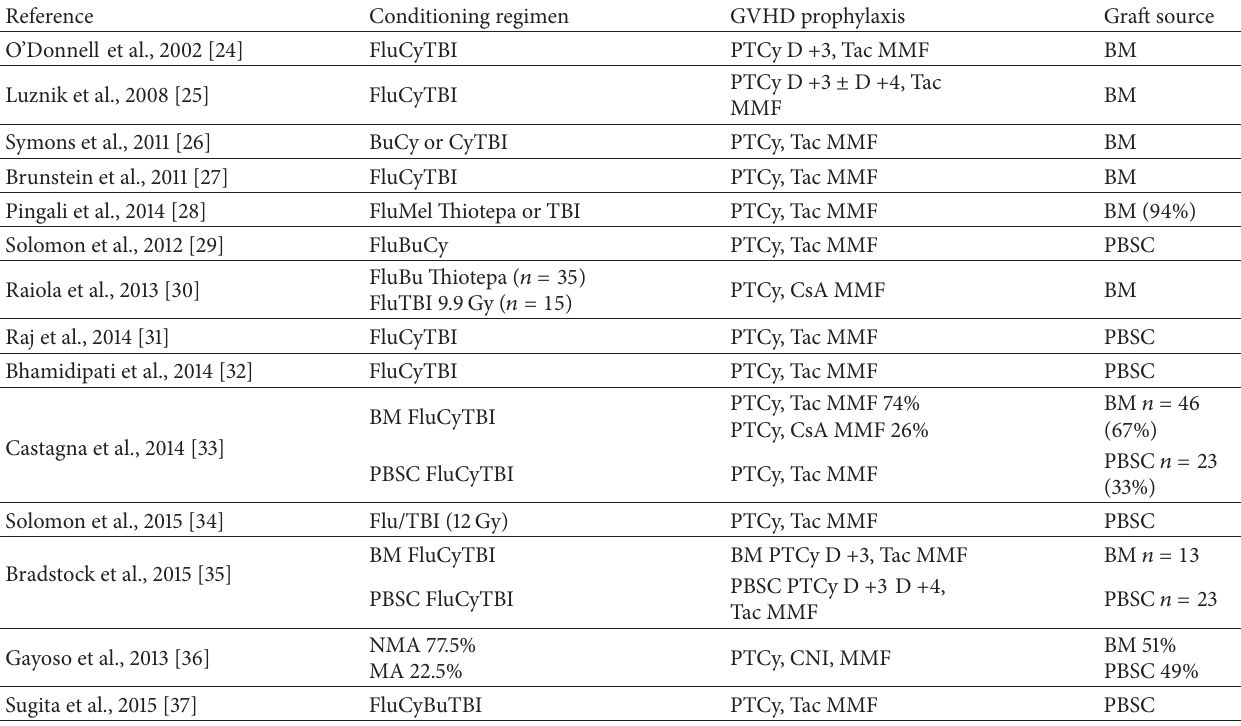
Table 1: Platforms of conditioning regimens, GVHD prophylaxis, and graft